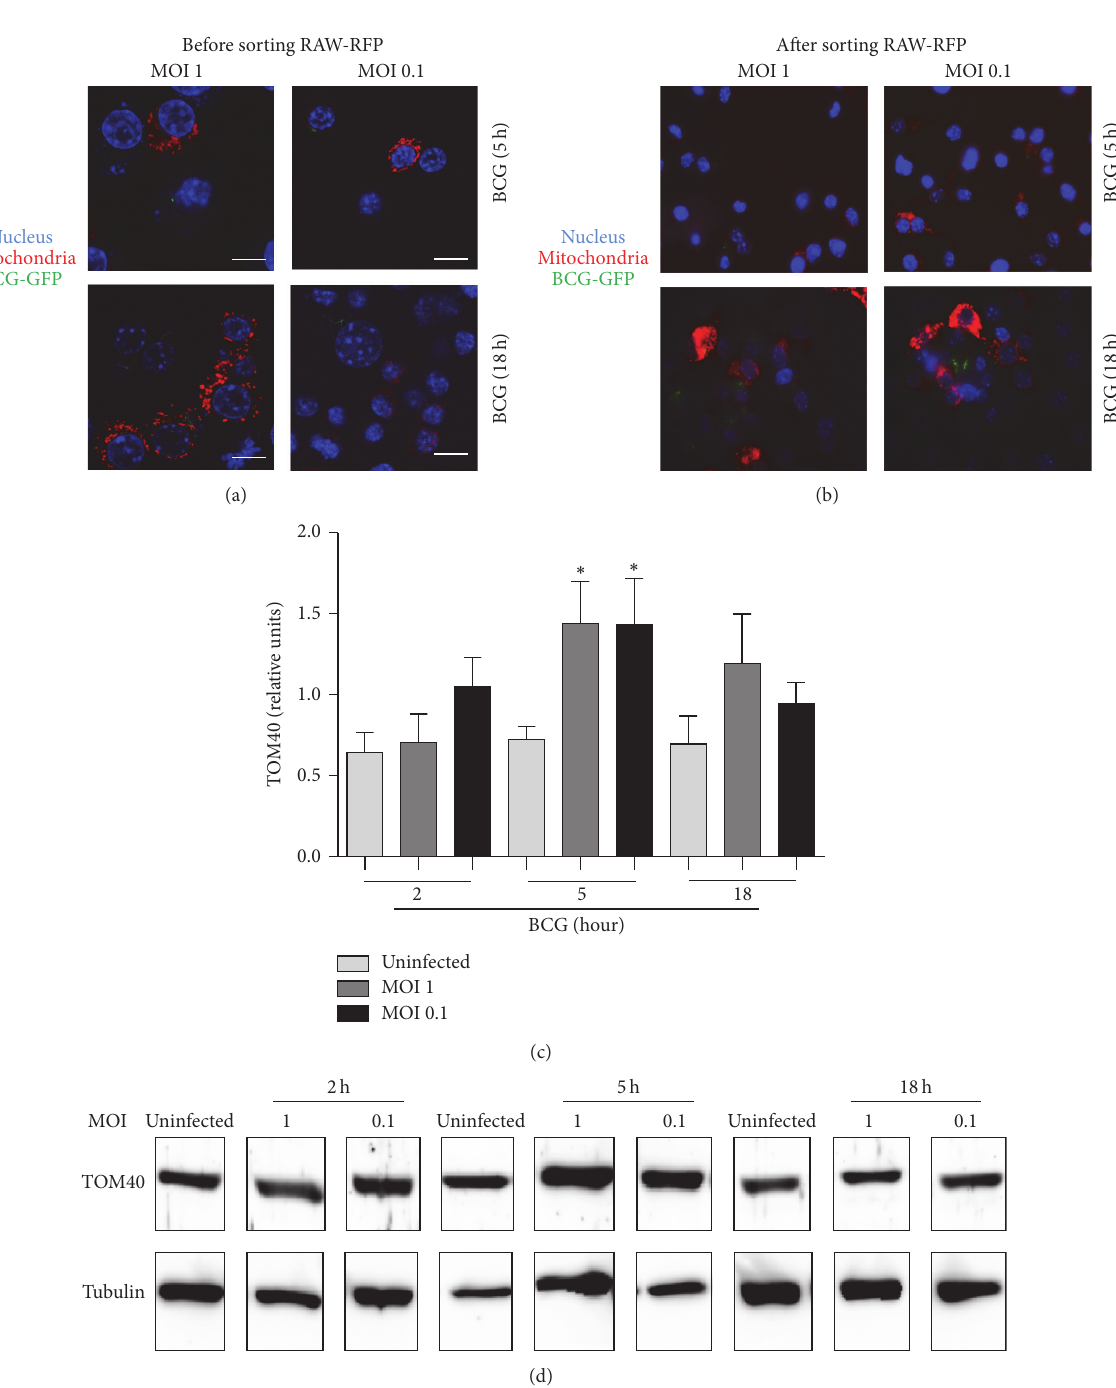
Figure 8: Amount of TOM40 is maintained at both MOI 1 and MOI 0.1. (a) RAW-mitoRFP macrophages were infected with BCG-GFP at MOI 1 and MOI 0.1 for 5 and 18h or (b) sorted for mitoRFP and then infected. (c) Western blots for TOM40, band densities were normalized againsttubulin.(d)Representativewesternblotfromthreeindependentexperiments.Two-tailedunpairedStudent’s 𝑡 -testwasusedtoevaluate statistical differences. Bars indicate mean ± SEM from three experiments. ∗ 𝑃 < 0.05